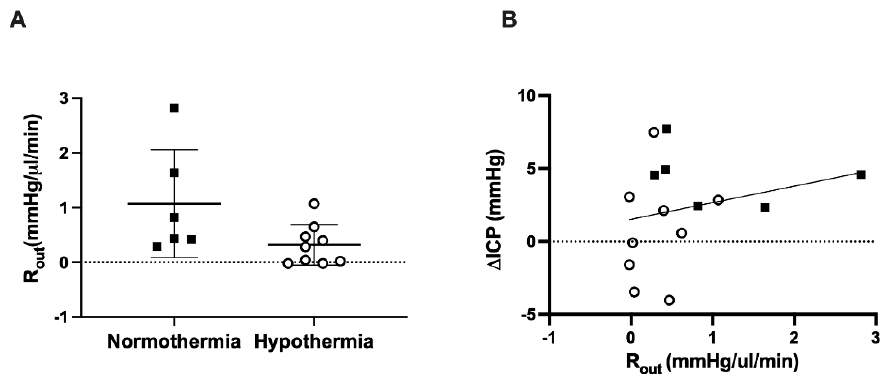
Figure 4. ( A ) R out values between hypothermia treated and normothermia controls. ( B ) Pearson correlation between ∆ ICP and R out in hypothermia animals (r 2 = 0.04, p = 0.61: white circles) and normothermia animals (r 2 = 0.09, p = 0.56: black squares).